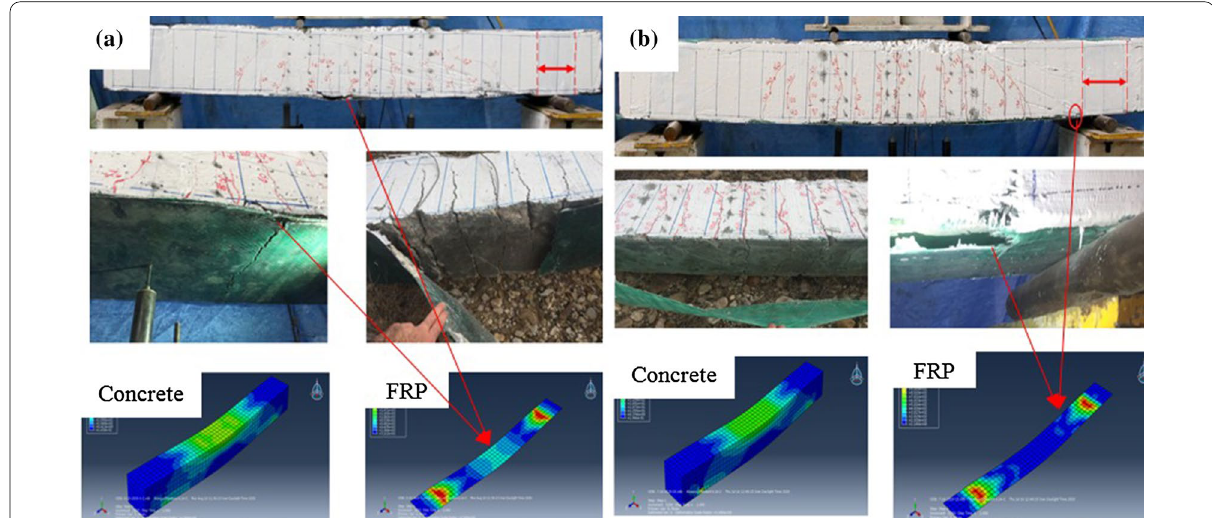
Fig. 26 Numerical and experimental failure modes of strengthened beams: a RCFRP, and b